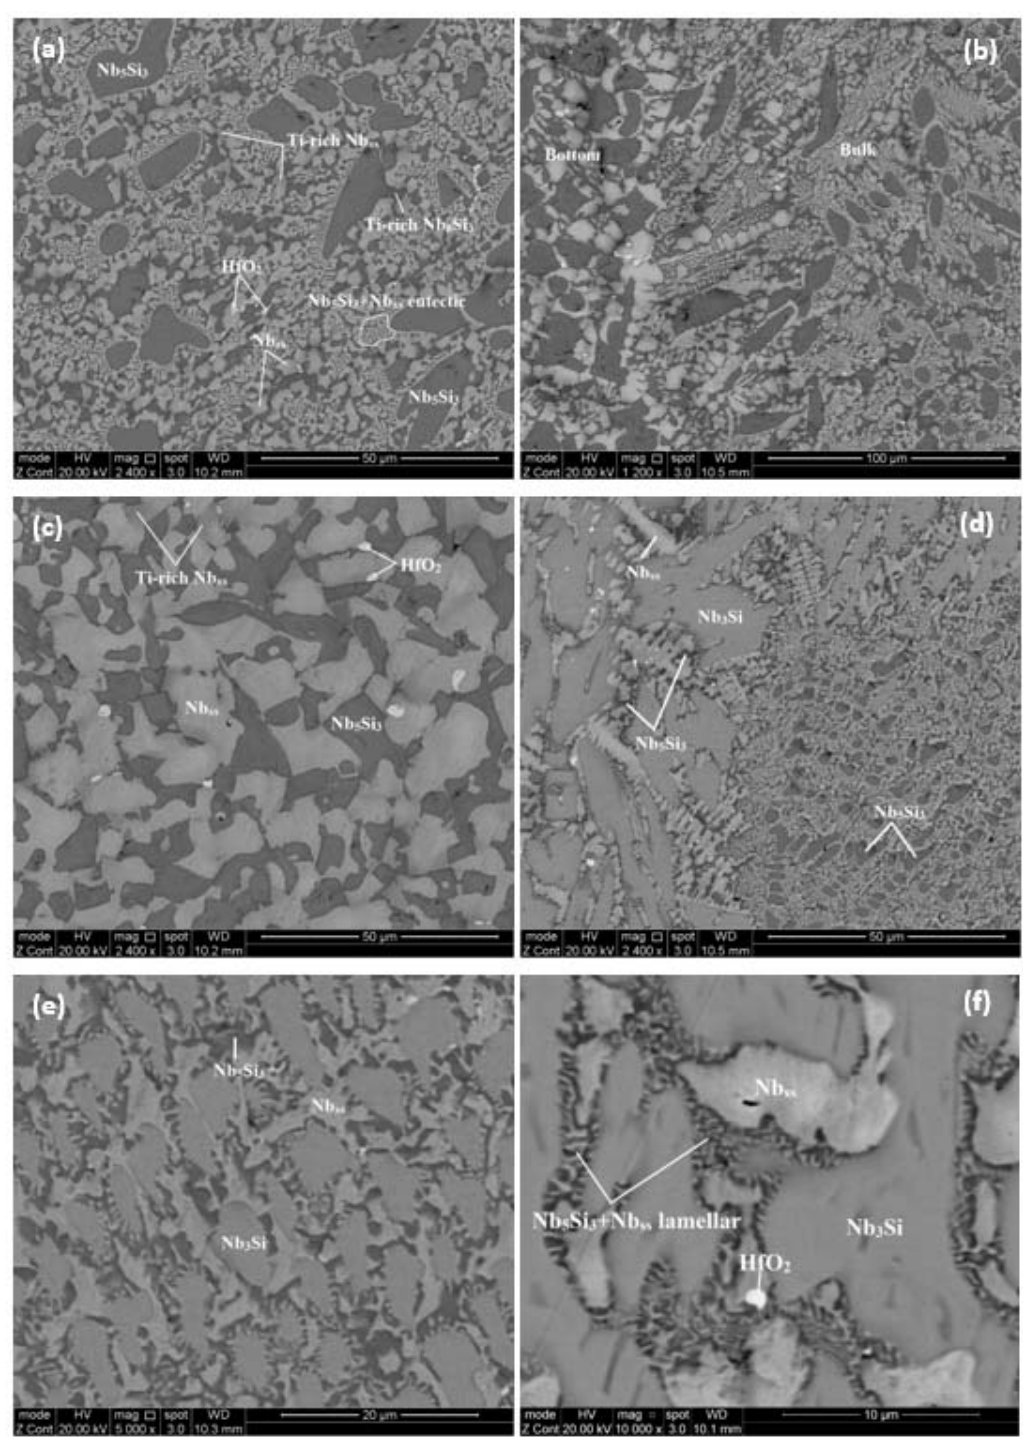
Figure 2. Backscattered electron (BSE) images of the microstructure of JZ1-AC in the ( a ) top and ( c ) bottom ( b ) showing the transition from the bulk to the bottom. ( d ) to ( f ) show the details of the microstructure in the bottom of the button of JZ1-AC where the Nb 3 Si silicide was observed. The microstructure in the bottom of the button contained only of Nb 5 Si 3 and Nb ss without the Nb 5 Si 3 + Nb ss eutectic (Figure 2c). The vol.% of Nb ss in the bottom was the same as in the